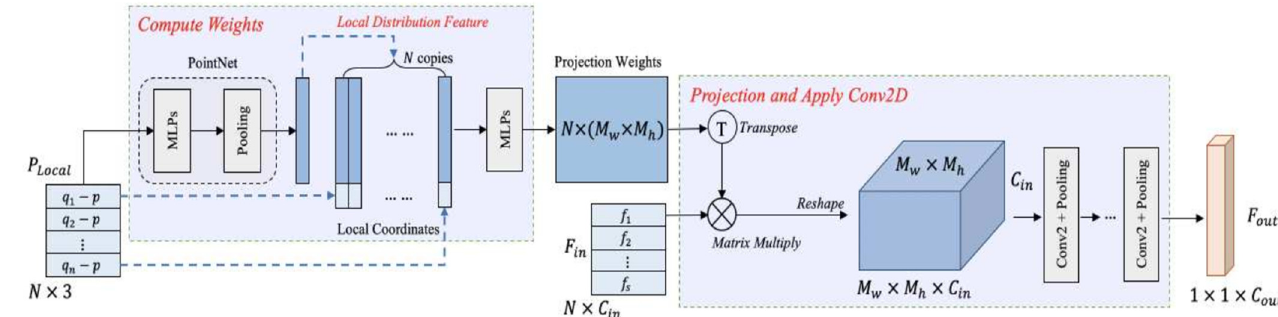
Figure 7. Network architecture diagram of FPConv. Reprinted with permission from ref. [45], 2020, CVPR 2020.